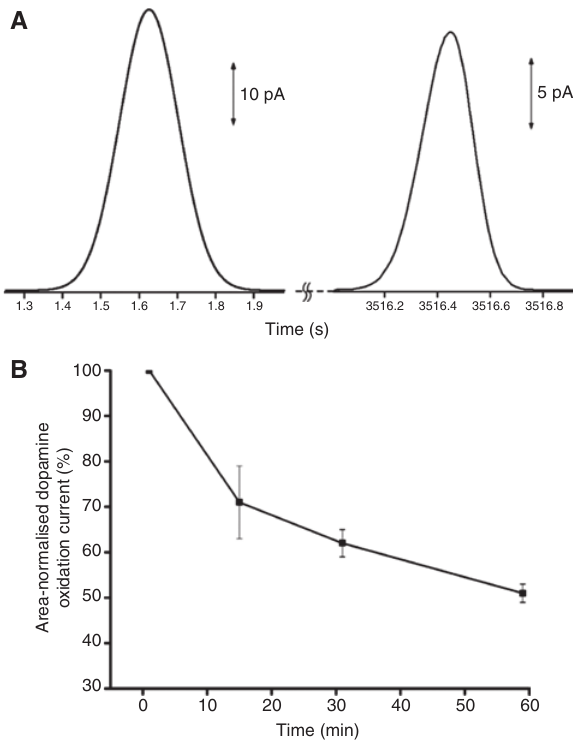
Figure 3: Gaussian-fitted dopamine oxidation signals obtained upon repeated electrical stimulations in the rat striatum at the start (left) and after 60 min (right) of monitoring at a hydrogenated carbon electrode (A) and a plot of electrode area normalised current measured over a 60-min period at hydrogenated carbon electrodes implanted in the rat striatum (B). Reproduced with permission from Chandra et al.